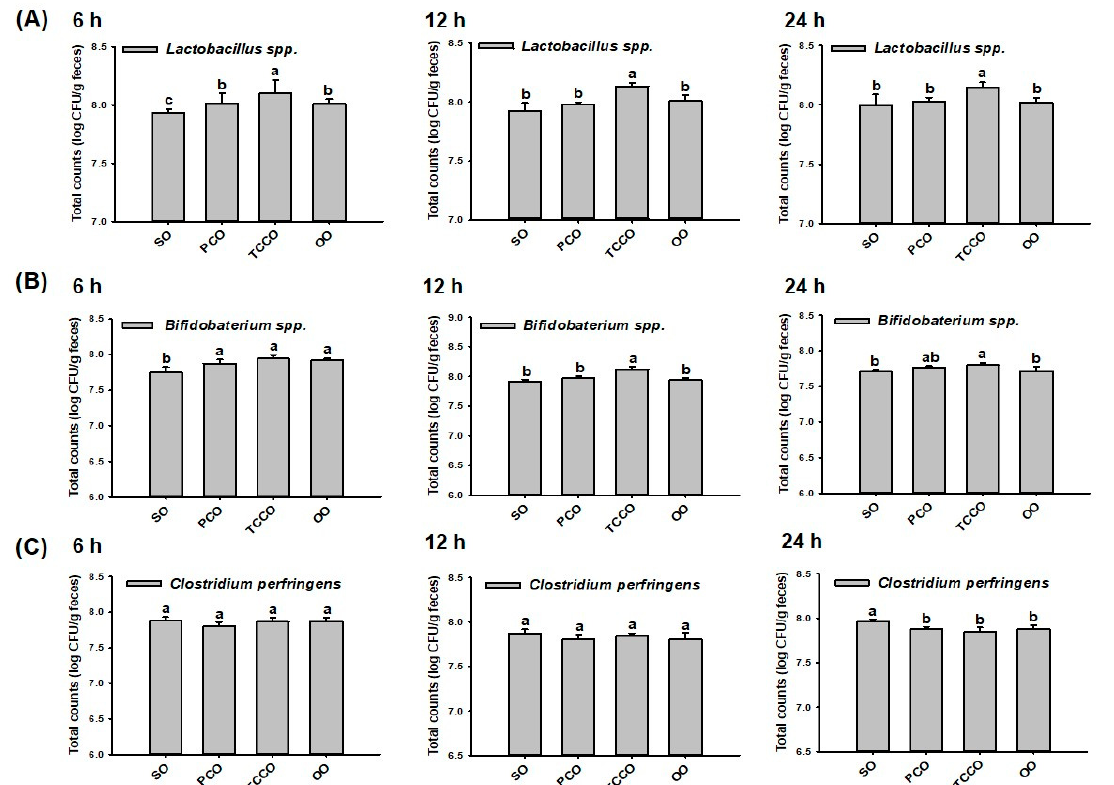
Figure 1. Gut microbiota ( A ) Lactobacillus spp., ( B ) Bifidobacterium spp., and ( C ) Clostridium perfringens in a batch-culture fermentation system containing SO, PCO, TCCO, and OO for in vitro fecal fermentation at 6 h, 12 h, and 24 h. The reported values are expressed as the mean ± standard deviation (SD) ( n = 3). Values assigned different letters are significantly different at p < 0.05, which was determined using Duncan’s multiple range test. SO, soybean oil; PCO, camellia oil ( Camellia oleifera ); TCCO, camellia oil ( C. brevistyla ); and OO, olive oil.